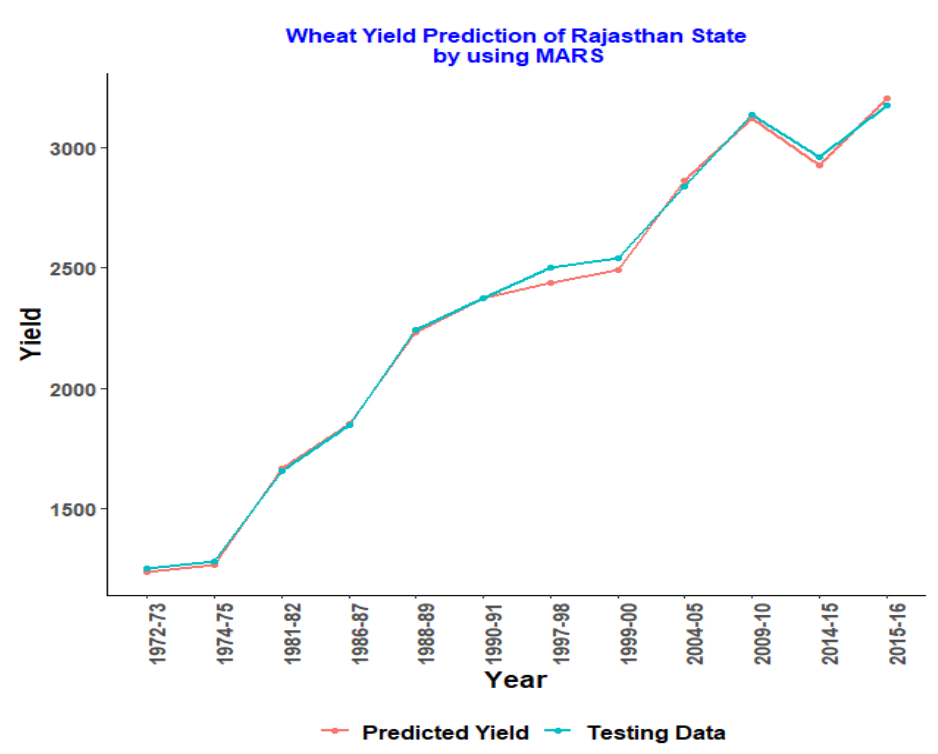
Figure 1. MARS model for overall India.